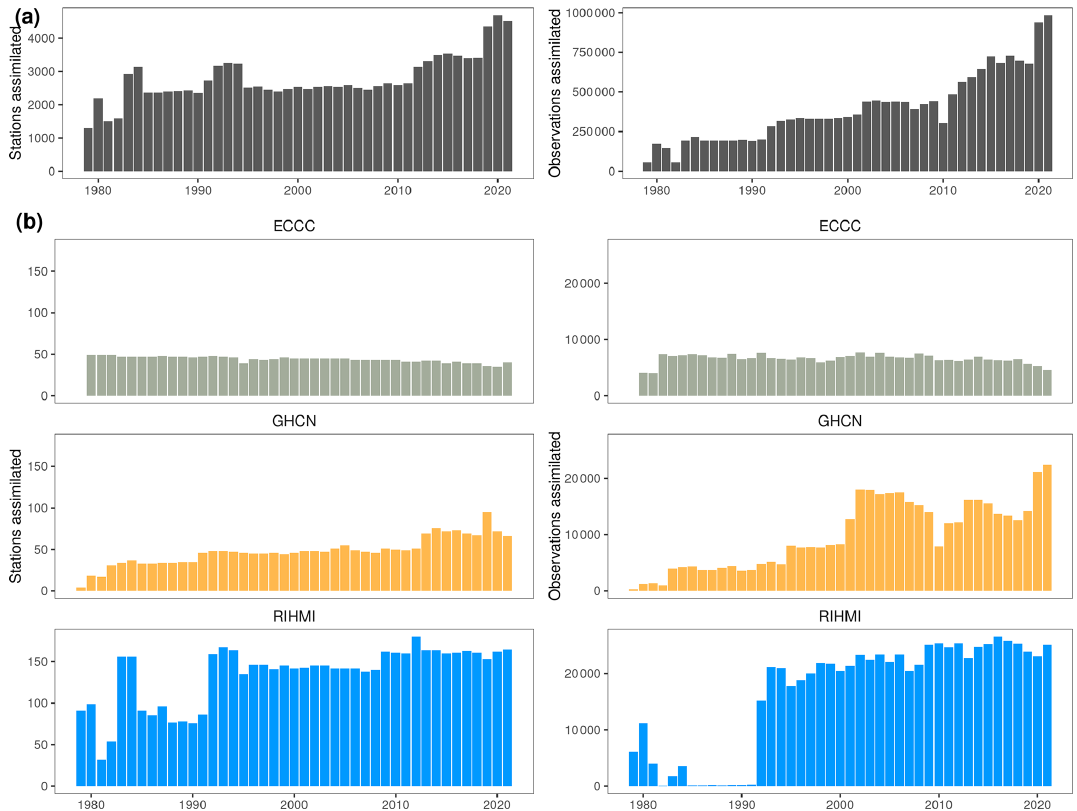
Figure 6. Temporal evolution of the in situ snow stations and observations assimilated by ERA5: (a) all stations assimilated by ERA5 and (b) stations assimilated by ERA5 within our validation